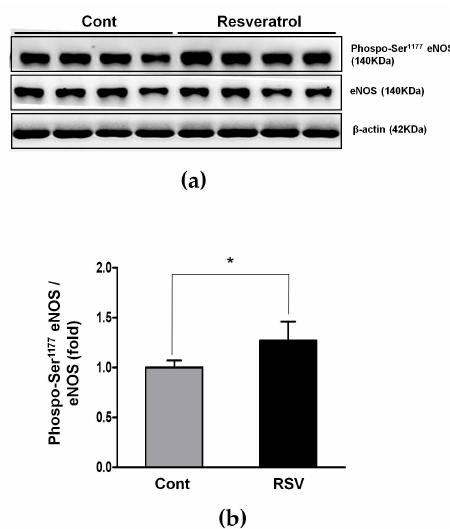
Figure 11. Effects of resveratrol on phospho-Ser1177eNOS/eNOS. ( a ) Representative western blots of phospho-Ser1177eNOS/eNOS levels. ( b ) The expression of phospho-Ser1177eNOS/eNOS was significantly increased in the RSV group. Quantitative analysis of the results is shown (* p < 0.05). SOD2 protein levels were increased in the resveratrol-treated mice (control 1.00 ± 0.02 vs. resveratrol 1.23 ± 0.06-fold, Figure 12).